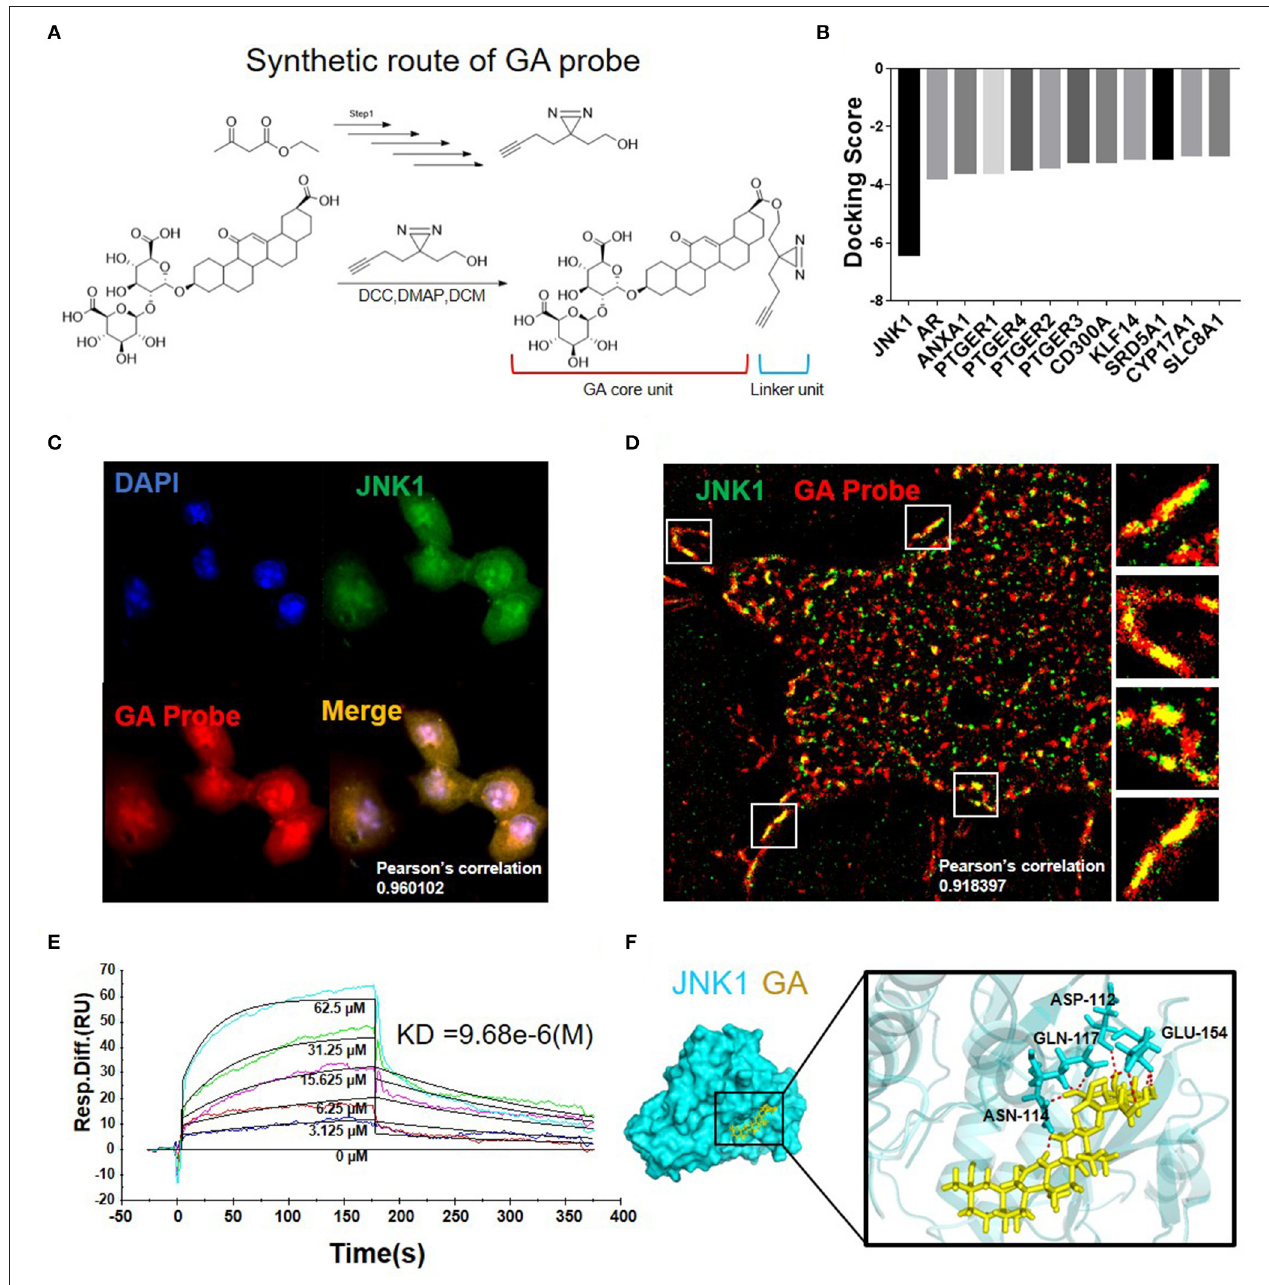
FIGURE 3 | Synthesis and target validation of GA probe. (A) Synthetic route and structure of the GA probe used in the study. (B) Molecular docking results of GA with multiple proteins. (C) Immunofluorescence co-localization of GA probe and JNK1. (D) N-STORM picture of GA probe bound with JNK1. (E) Biacore analysis revealed that GA can bind well with JNK1. (F) Image of molecular dynamics simulation visualizes the combination of GA with